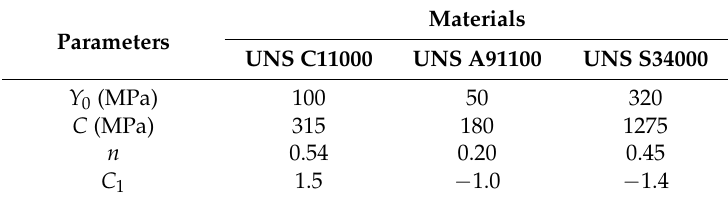
Table 1. Values of the Y 0 and n [41] and C and C 1 [23,24] for the three real materials used. Parameters